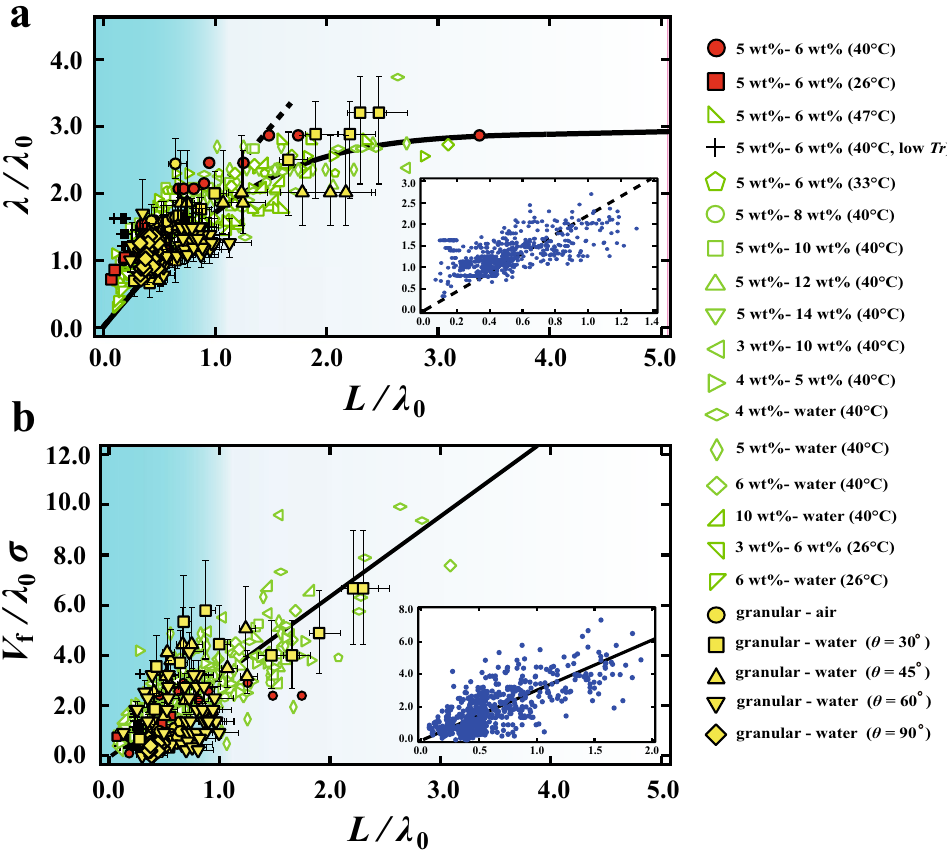
Figure 8. ( a ) (cid:31) / (cid:31) 0 as a function of L / (cid:31) 0 . For smaller L / (cid:31) 0 , (cid:31) / (cid:31) 0 is linear with respect to L / (cid:31) 0 (dashed line in ( a )). The solid line is an eye guide for the entire process of the Rayleigh–Taylor-like instability. The region colored by blue background corresponds to the linear regime of the Rayleigh–Taylor-like instability. The inset shows (cid:31) / (cid:31) 0 near the origin. The dots are used in order to see all data clearly. ( b ) V f / (cid:31) 0 σ as a function of L / (cid:31) 0 . The solid line is linear fitting for V f / (cid:31) 0 σ . The inset shows V f / (cid:31) 0 σ near the origin. The dots are used in order to see all data clearly. (cid:31) / (cid:31) 0 and V f / (cid:31) 0 σ in physical gels are scaled by L , regardless of T b . Furthermore, (cid:31) / (cid:31) 0 and V f / (cid:31) 0 σ in the granular systems are also